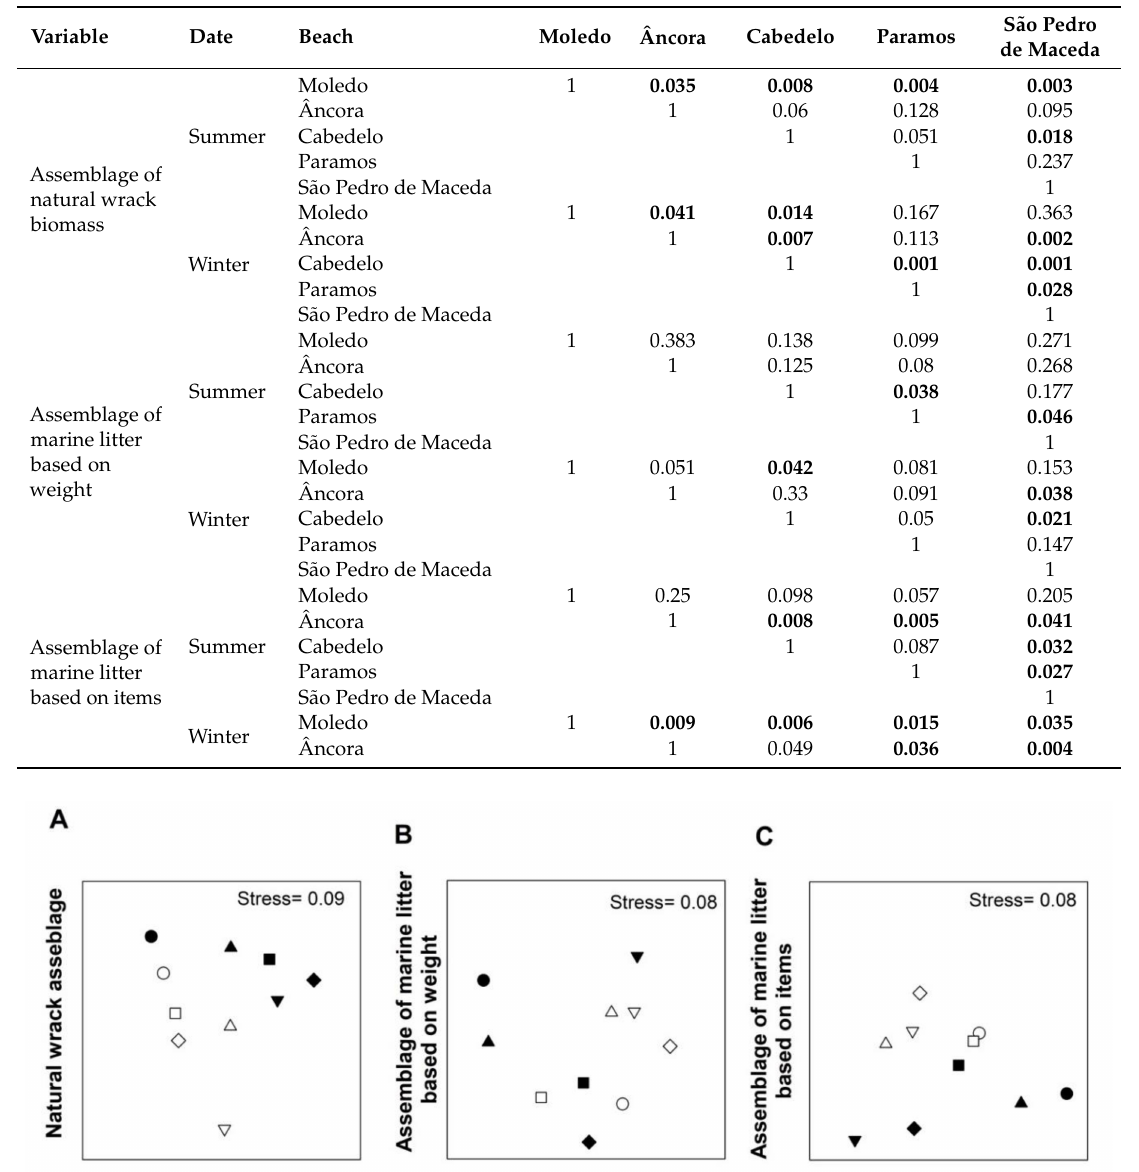
Table 3. Multivariate pair-wise comparison of wrack assemblages and marine litter for the term Beach × Date. Significant di ff erences are highlighted in bold ( p < 0.01).